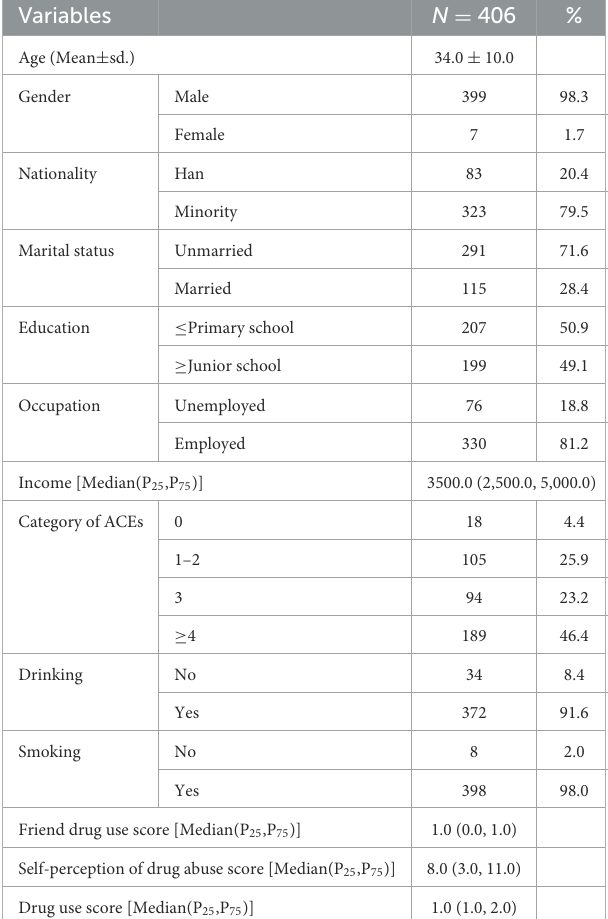
TABLE 1 Socio-economic-demographics and respondents’